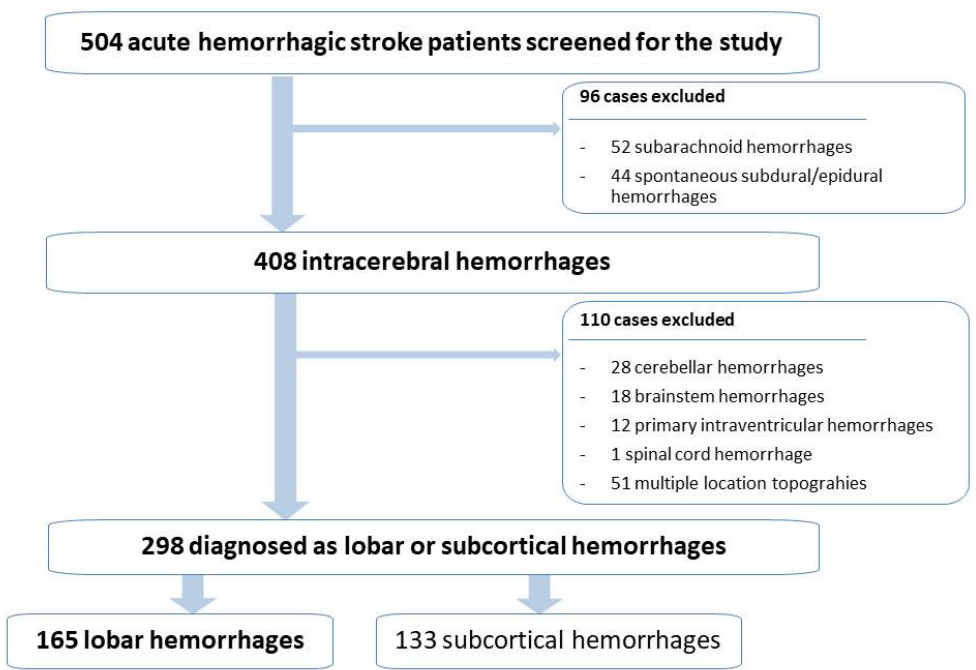
Figure 2. Schematic workflow of the study considering the different topographic subtypes of spon- taneous acute intracerebral hemorrhagic stroke.